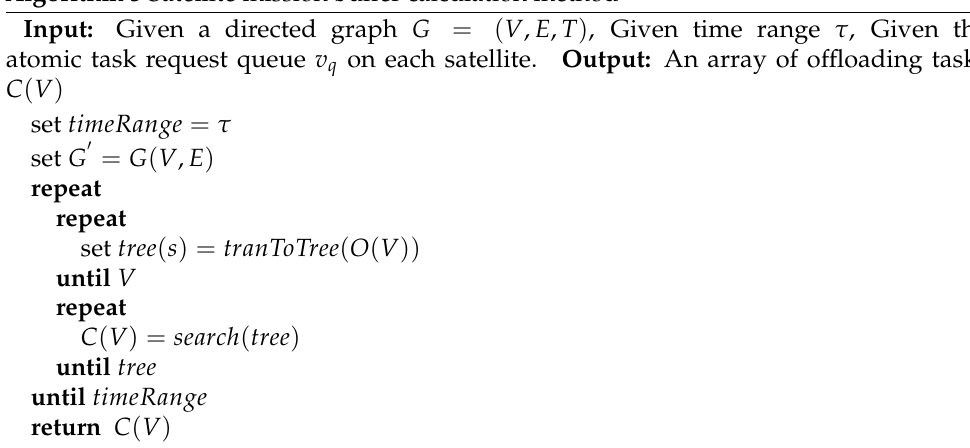
Algorithm 3 Satellite mission buffer calculation